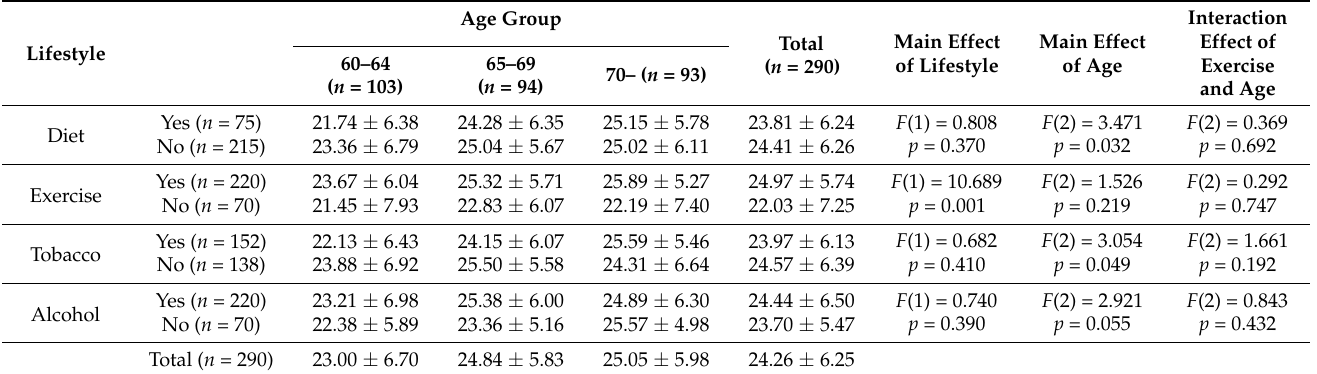
Table 3. Descriptive statistics and two-way ANOVA for life satisfaction levels on the SWLS by lifestyle and age